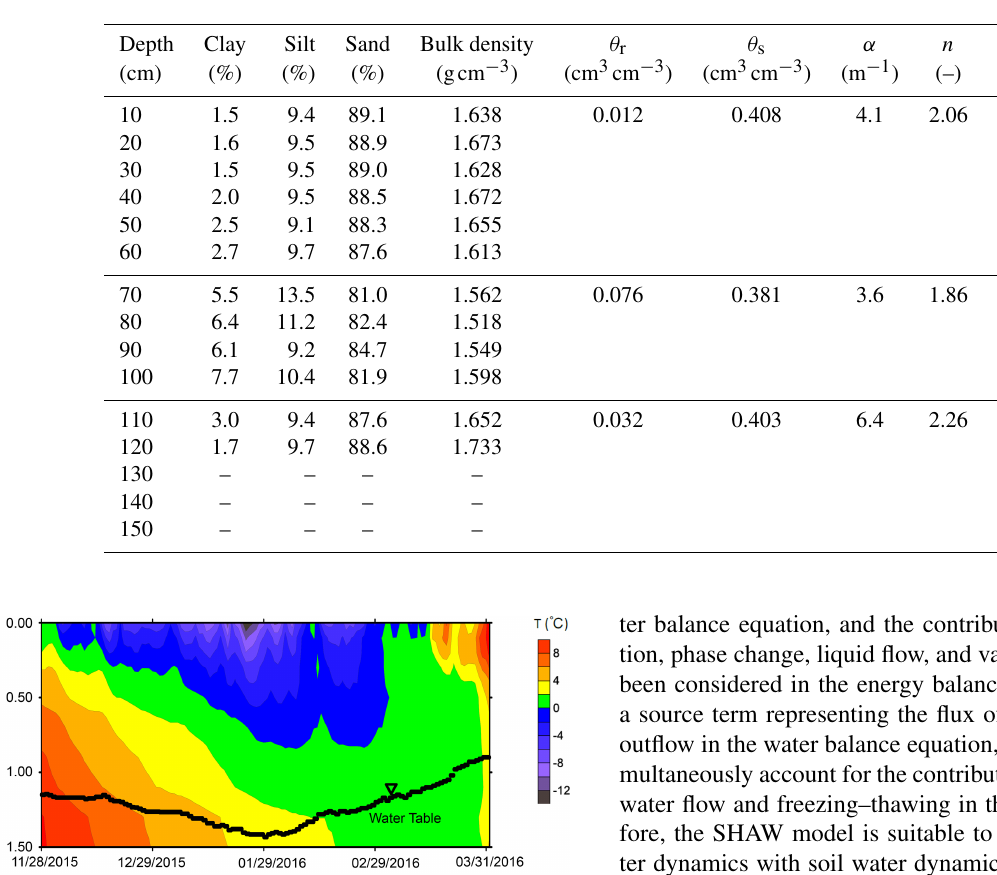
Table 1. The measured soil texture and bulk density and calibrated hydraulic parameters.